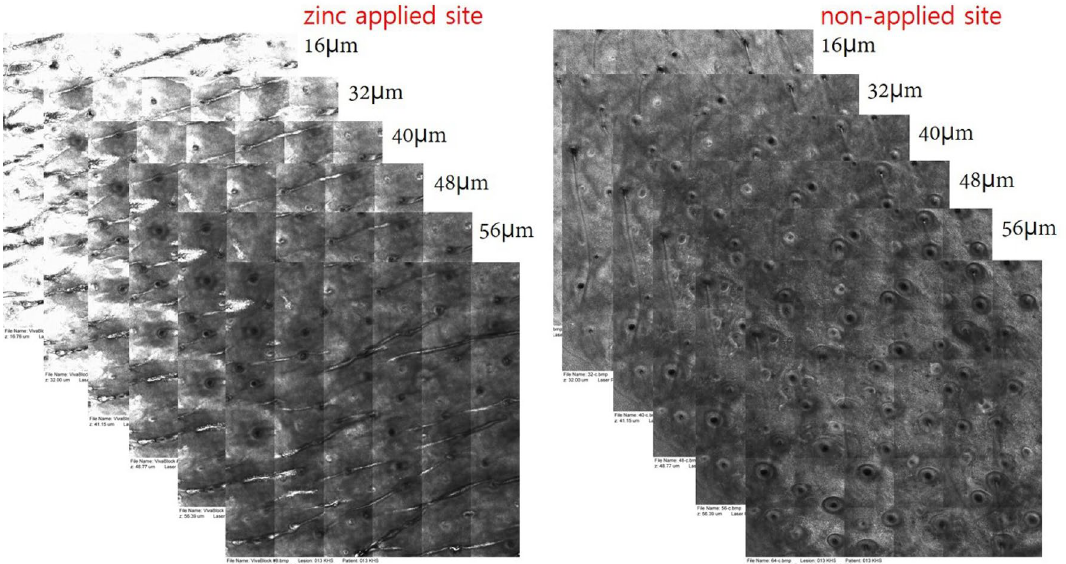
Figure 4. RCM images after zinc application. After zinc application, the facial skin showed higher reflectance than the non-applied zinc facial skin at different